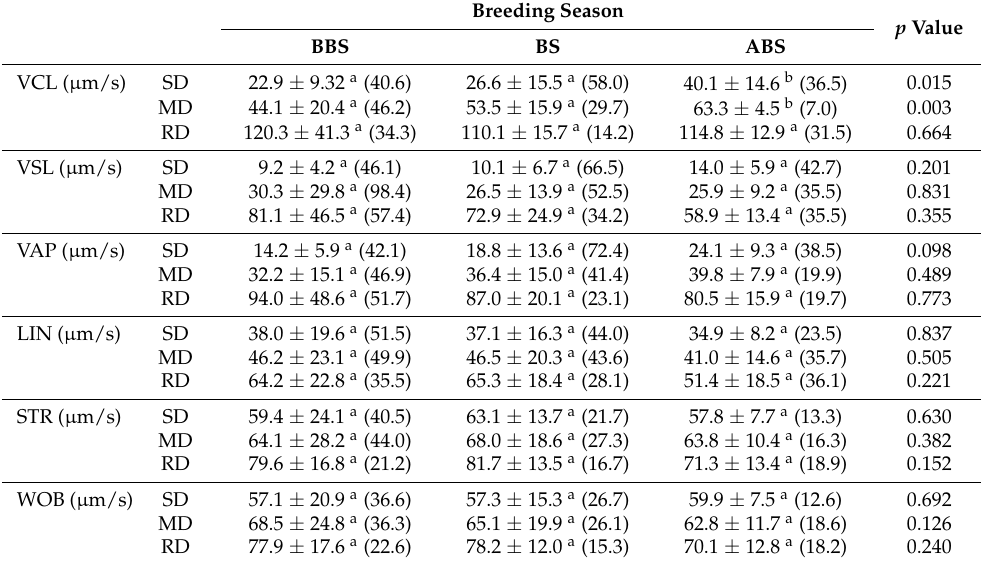
Table 2. Sperm motility characteristics (mean ± SD (CV%)) of advanced semen evaluation test, computer-assisted sperm analysis (CASA), in the selected periods of routine ram examination in the herd, before the breeding season (BBS), during the breeding season (BS), and after the breeding season